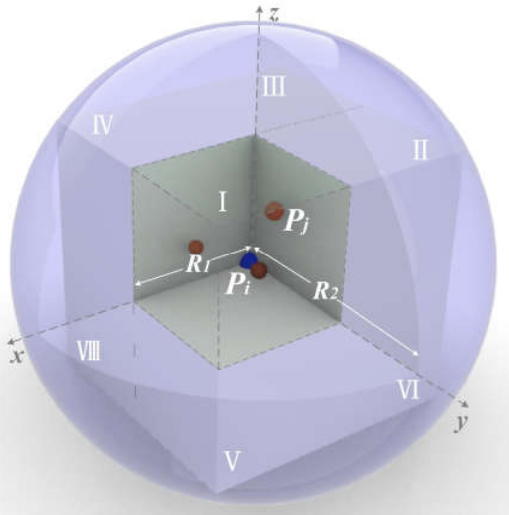
Figure 9. MS-LBP schematic diagram. I–VIII represent the voxels in eight quadrants, where the blue sphere represents the detection point, the red spheres represent the internal points of each voxel, R 1 represents the side length of the voxel in each quadrant and R 2 represents the search radius in the neighborhood of the detection point.